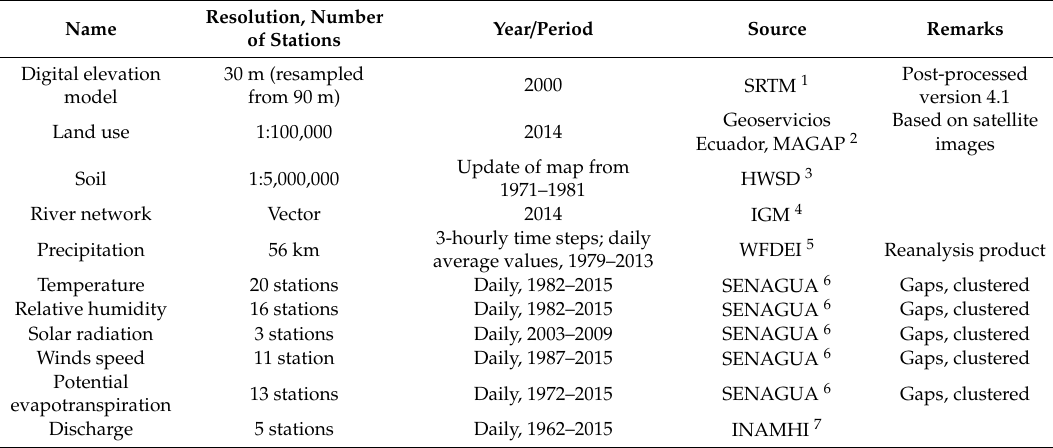
Table 1. Model input data sources for the Guayas River basin. Gaps refer to missing data in the time series, whereas clustered refers to measurements obtained from stations that are heterogeneously distributed throughout the basin. Details can be found in Section C.1. of Supplementary